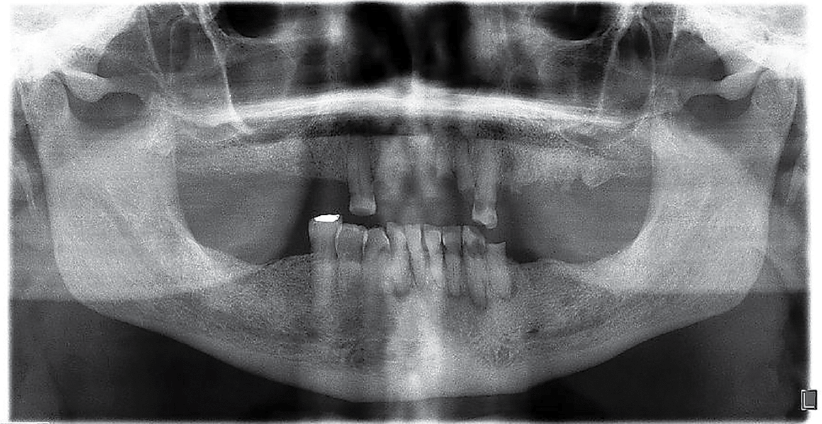
Figure 4- Case 14. Both mandibular premolar-molar zones are occupied by two giant mixed images associated to dental extraction. Maxillary left lateral incisor and mandibular left canine were congenitally